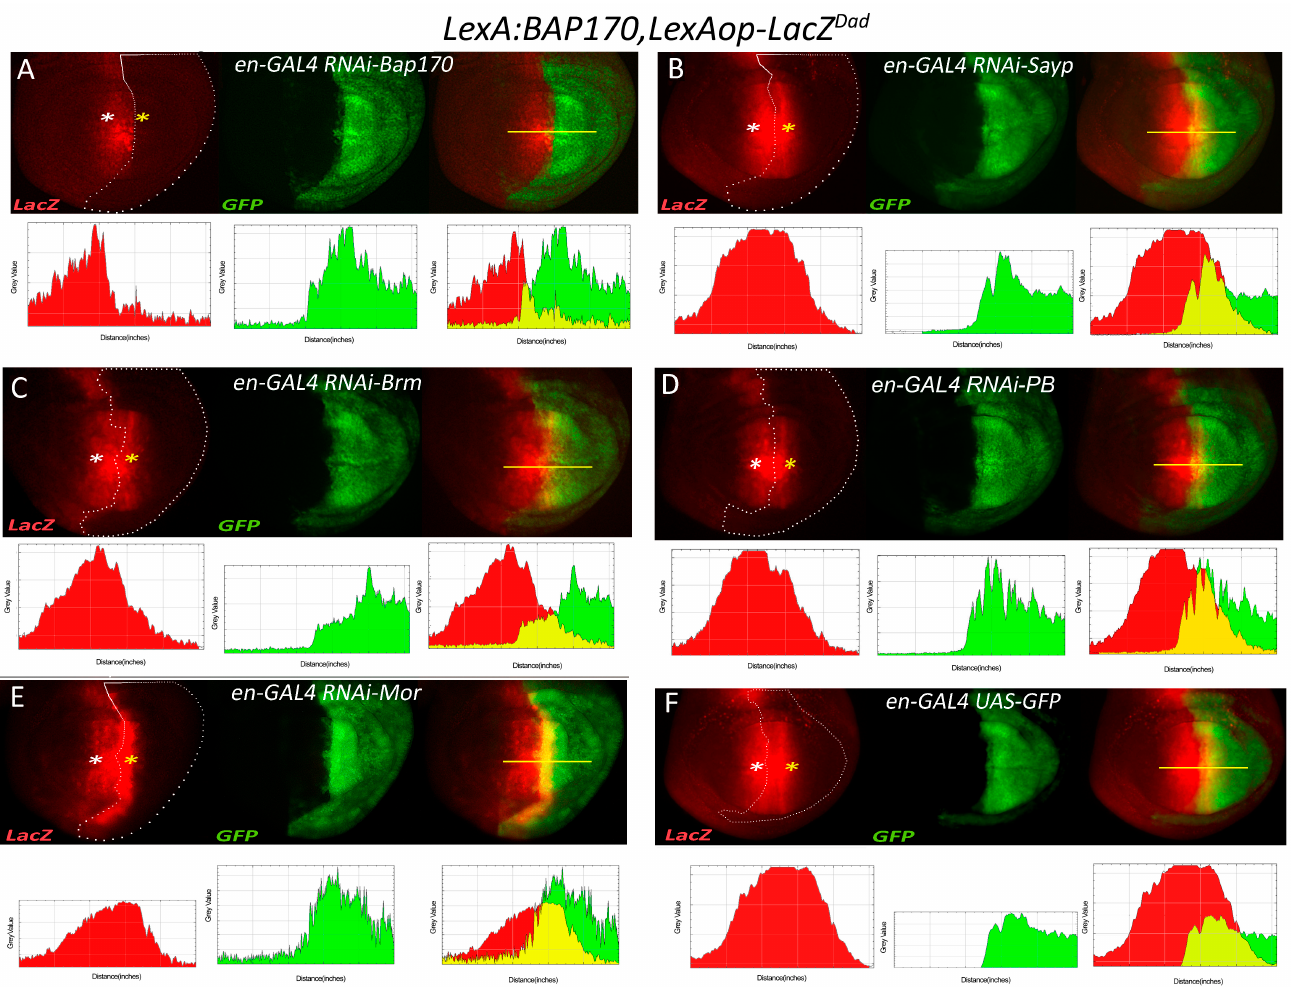
Figure 7. Targeted BAP170 can capture the enhancer independently by SAYP and the PBAP complex core. Fluorescence imaging of beta-gal (red) and GFP (green) expression in the wing discs from larvae of the genotype en-GAL4, UAS-GFP/+; P BAP170 -LexA:BAP170, LexAop-LacZ Dad /+ transgenes in combination with RNAi lines for BAP170 ( A ), SAYP ( B ), BRM ( C ), PB ( D ), and MOR ( E ). White asterisks indicate the regions with normal LexAop-LacZ Dad transgene expression (outside the region of RNAi induction), and yellow asterisks indicate the regions that overlap the RNAi line activation. Genotypes: ( A ) en-GAL4 , UAS-GFP/+ ; P BAP170 -LexA:BAP170 , LexAop-LacZ Dad /UAS-RNAi-BAP170 [Vdrc34582] , ( B ) en-GAL4 , UAS-GFP/+ ; P BAP170 -LexA:BAP170 , LexAop-LacZ Dad /UAS-RNAi-SAYP [Vdrc105946] , ( C ) en-GAL4 , UAS-GFP/+ ; P BAP170 -LexA:BAP170 , LexAop-LacZ Dad /UAS-RNAi-Brm [Vdrc37721] , ( D ) en-GAL4,UAS-GFP/+ ; P BAP170 -LexA:BAP170 , LexAop-LacZ Dad /UAS-RNAi- PB [Vdrc108618] , ( E ) en-GAL4 , UAS-GFP/+ ; P BAP170 -LexA:BAP170 , LexAop-LacZ Dad /UAS-RNAi-Mor [Vdrc6969] , ( F ) the control stock en-GAL4 , UAS-GFP/+ ; P BAP170 -LexA:BAP170 , LexAop-LacZ Dad /+ . The plots under each wing disc panel show the intensity of staining for each color along the line at the antero/posterior boundary (yellow line in each left merged image). A dotted line encompasses the area of GFP